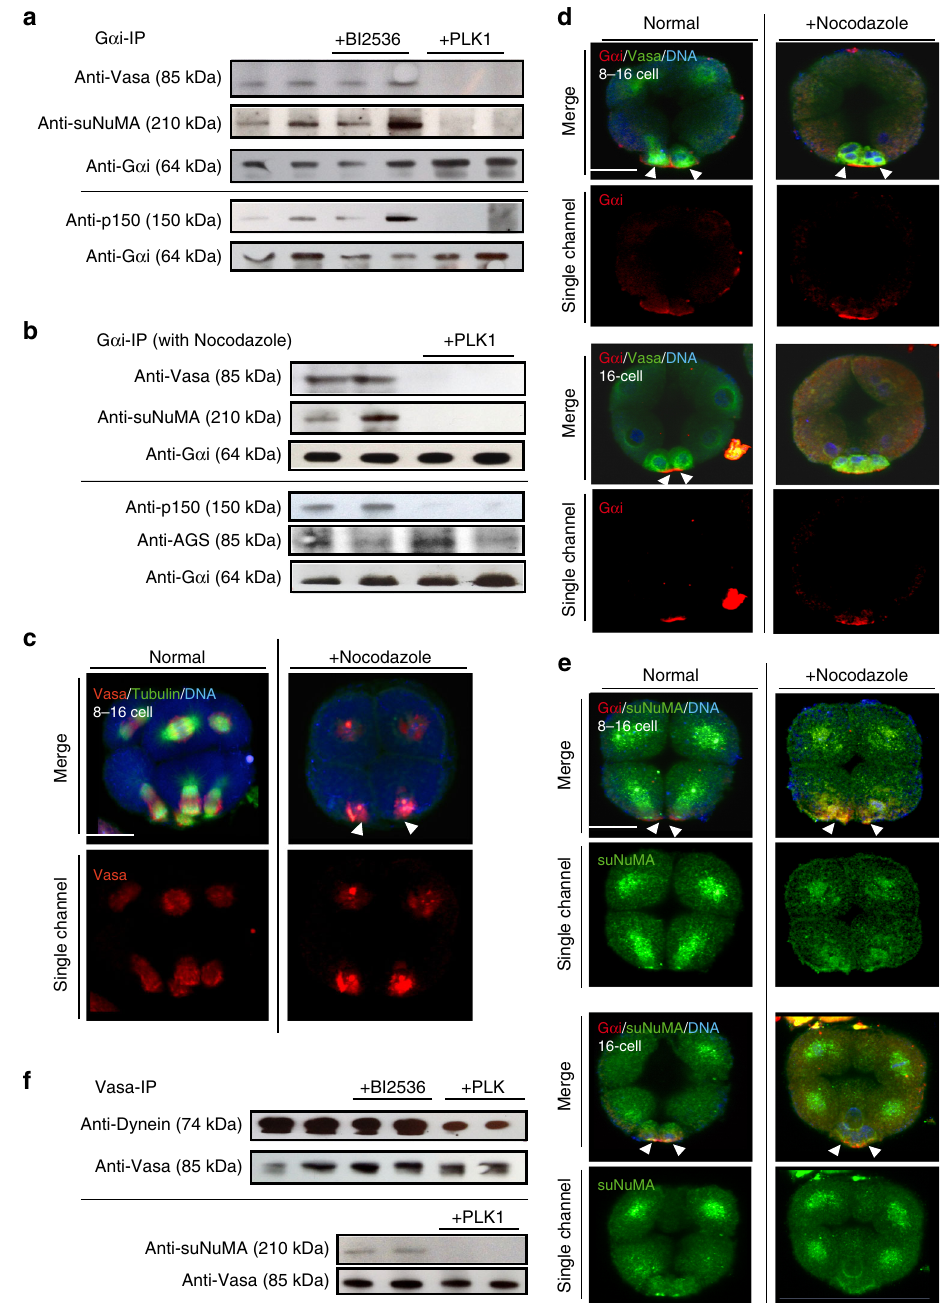
Fig. 2 Stability of the regulatory protein complex at the vegetal cortex is sensitive to PLK1 activity. a G α i-IP results. suNuMA, AGS and dynein interact with G α i in extracts from the 8 – 16 cell stage. b G α i-IP was performed after treatment with Nocodazole to destabilize microtubules. c – e Embryos were treated with Nocodazole at 8 – 16 cell stage for 10 min to disturb microtubule polymerization. c Nocodazole diminished spindle but Vasa (red) remained asymmetrically localized at the vegetal cortex independent of microtubules. d Vasa (green) remained at the close proximity to G α i (red) after the treatment (arrowheads). e suNuMA (green) also remained linked to the G α i (red) signal at the vegetal cortex after the treatment with Nocodazole (arrowheads). Scale bars = 520 μ m. f Vasa-IP results. Vasa interacts with dynein and suNuMA in the absence of PLK1. In a, b, f, IPs were conducted at least three independent times and two each of the IP-ed samples are shown. Each of the top and bottom groups of immunoblots (demarcated by the line) was processed from a single blot. () indicates the molecular weight of each protein. The representative phenotypes of 70% or larger in each population are shown ( n = 30 or